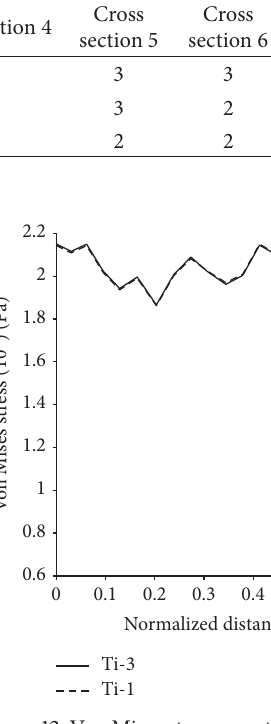
Figure 12: Von Mises stress over the external anterior surface of the bone.